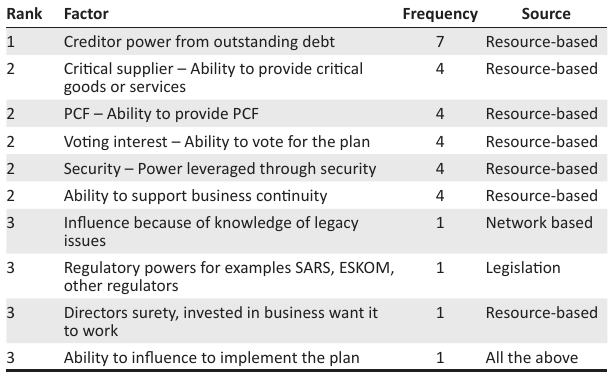
TABLE 3: Factors that contribute to stakeholder influence. Rank